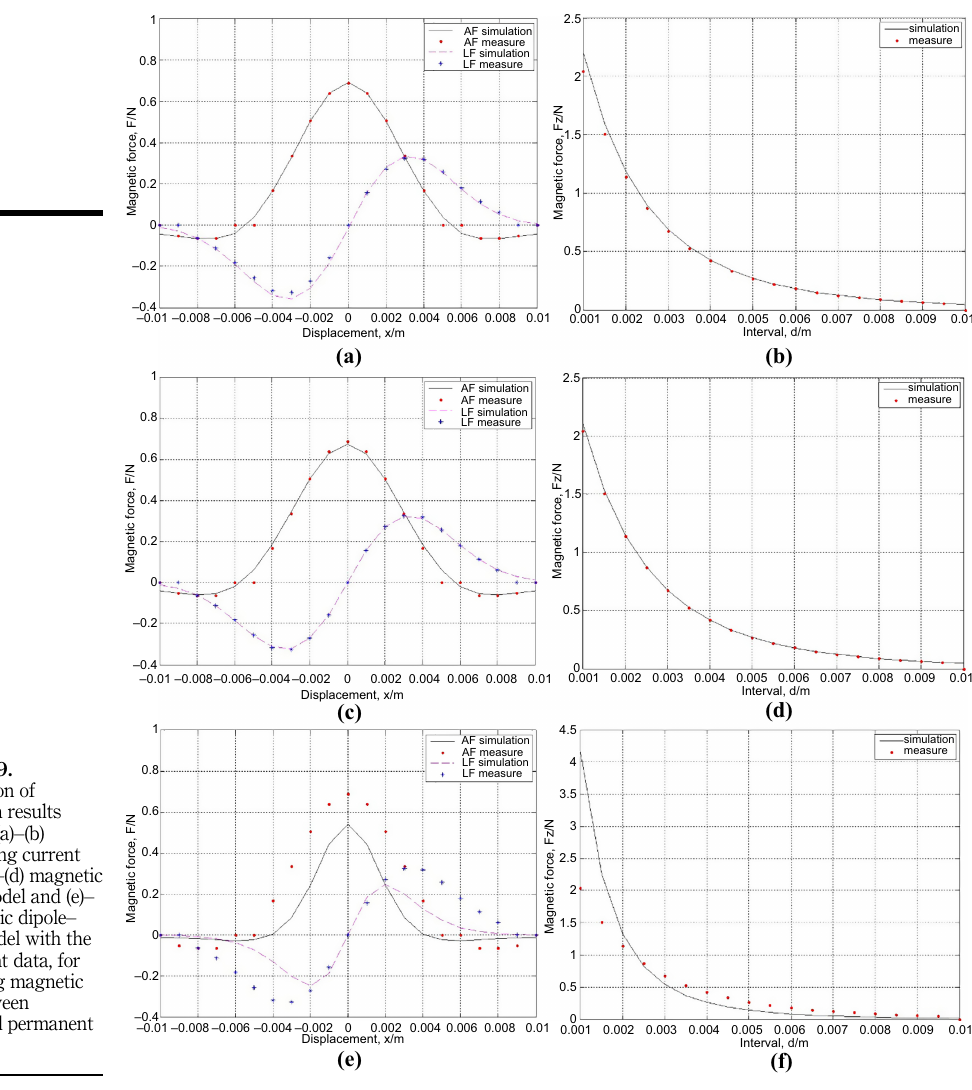
Figure 19. Comparison of simulation results based on (a) – (b) magnetizing current model, (c) – (d) magnetic charge model and (e) – (f) magnetic dipole – dipole model with the experiment data, for interacting magnetic force between cylindrical permanent